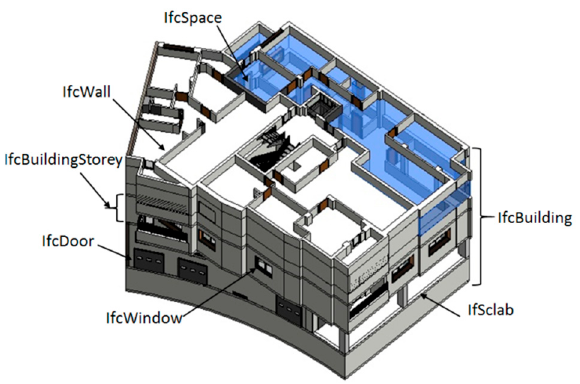
Figure 4. Relevant IFC spatial and physical entities for 3D Cadastre (inspired from [25]).